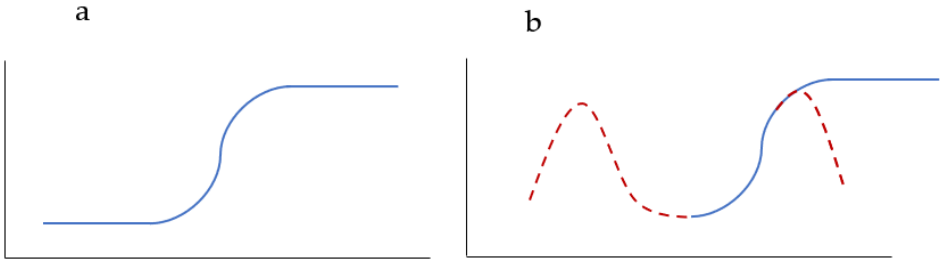
Figure 8. Schematic representation of hemolysis curves for: the current paradigm, where hemolysis begins to increase at some concentrations, then reaches 100% and remains at a 100% plateau with a further concentration increase ( a ), and for cases including the possibility of bell-shaped hemolysis profiles ( b ).